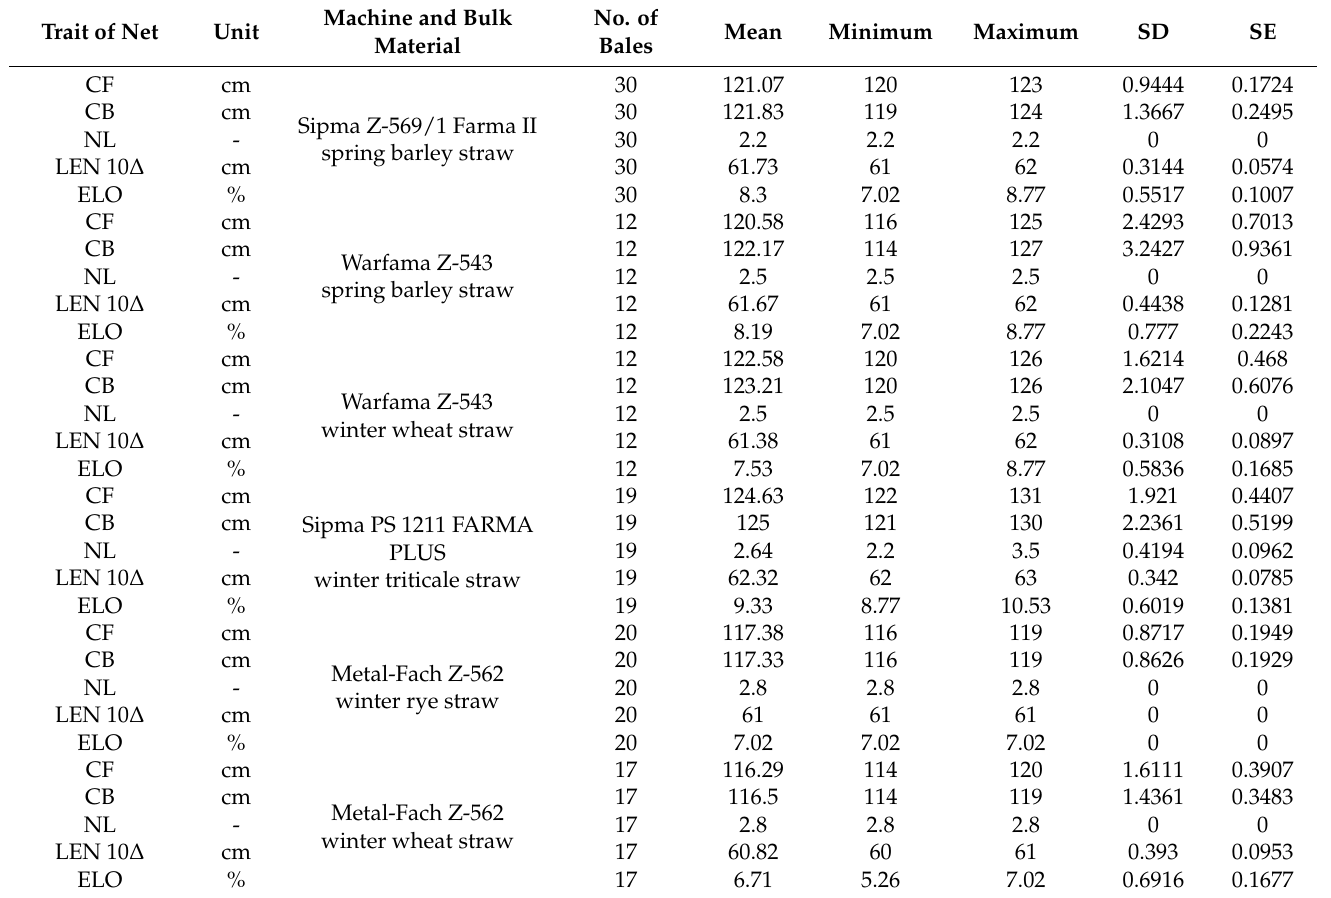
Table 5. Descriptive statistics of round balers collecting straw after harvesting cereals.